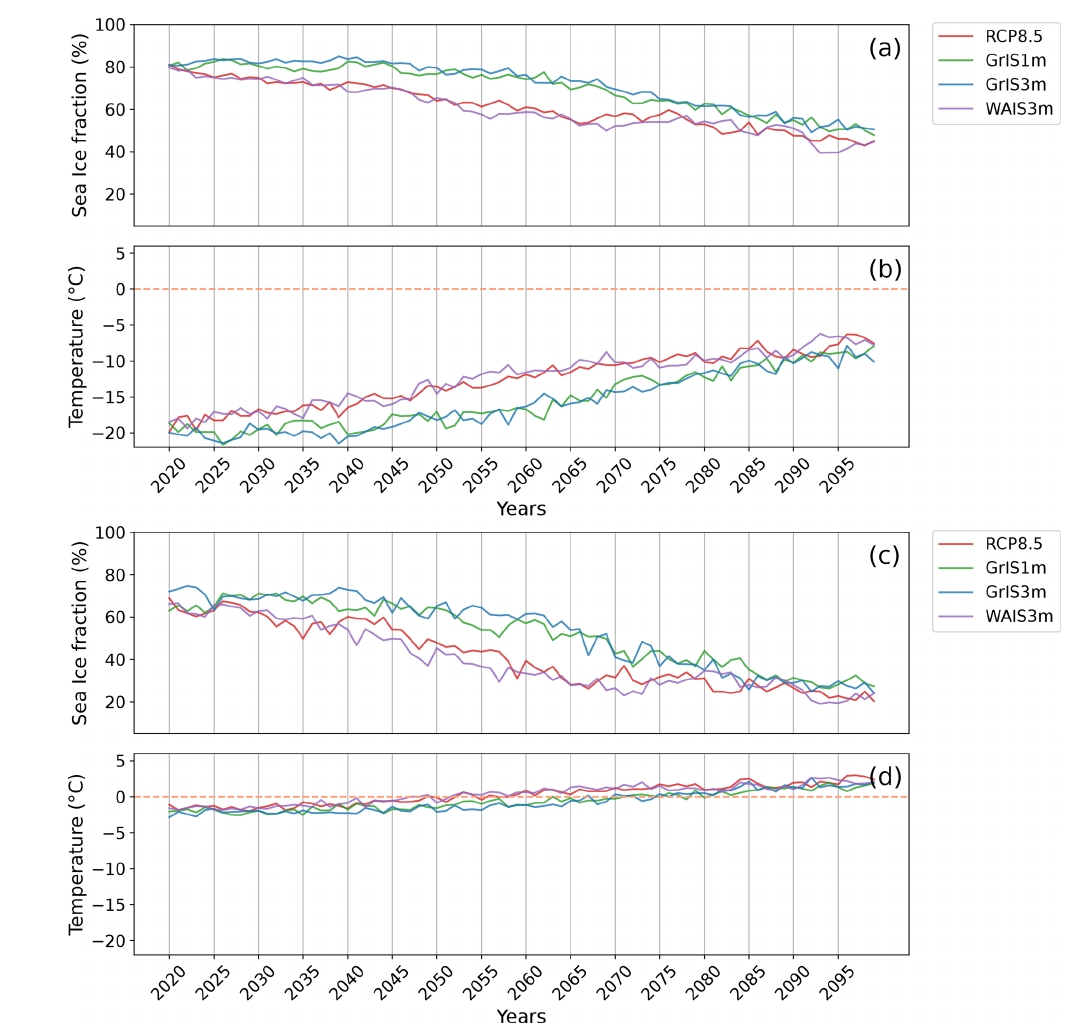
Figure B5. Temporal evolution of (a–c) sea ice fraction (%) and (b–d) temperature ( ◦ C) in the Northern Hemisphere for (a, b) NDJFM and (c, d) MJJAS. The orange dotted line represents the 0 ◦ C isotherm.